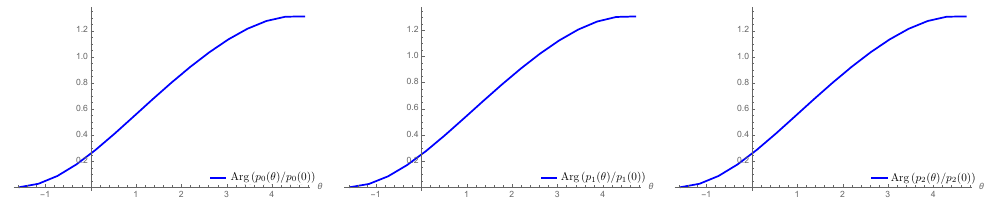
Figure 3 . Examples of the monodromy of p singularities: x +